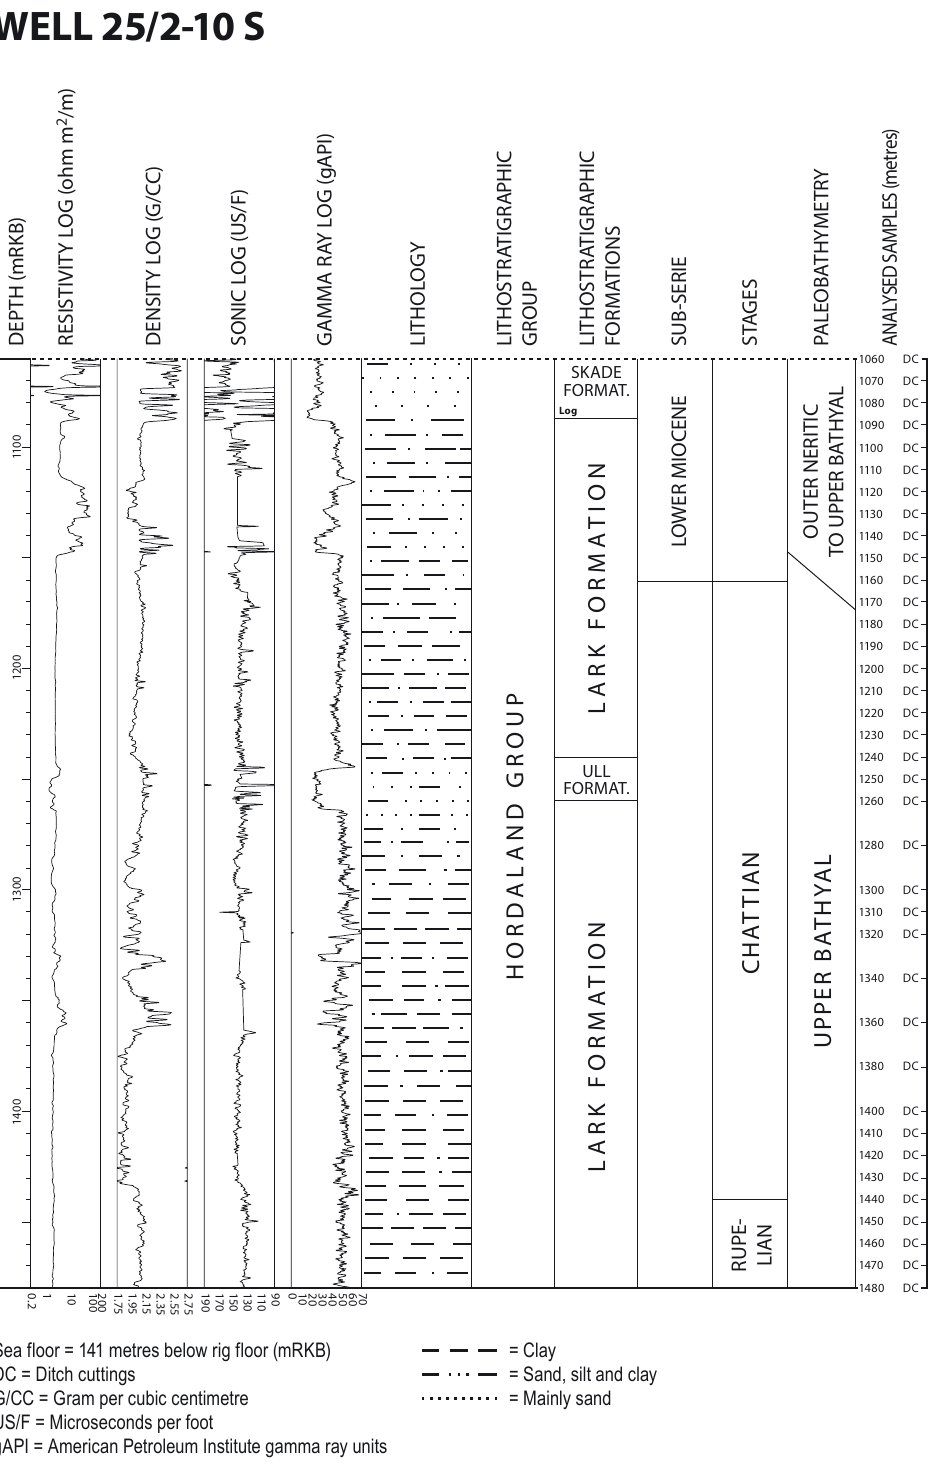
Figure 49. Well summary figure including resistivity log, density log, sonic log, gamma-ray log, lithology, litho- stratigraphic units, sub-series, stages, paleobathymetry and analysed samples for the lower part of the investigated sequence in well 25/2–10 S (Chattian to lower Miocene; modified after Eidvin et al.,